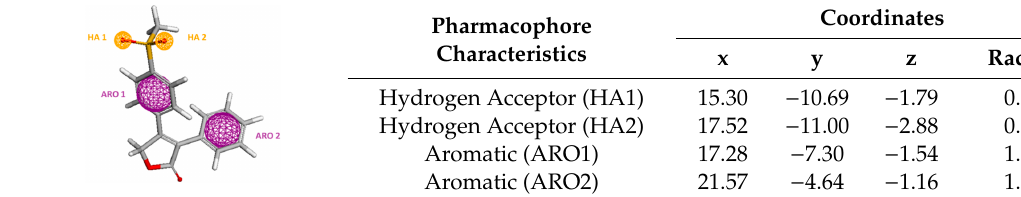
Molecules 2020 , 25 , x FOR PEER REVIEW Table 5. Pharmacophore characteristics. Table 5. Pharmacophore characteristics.